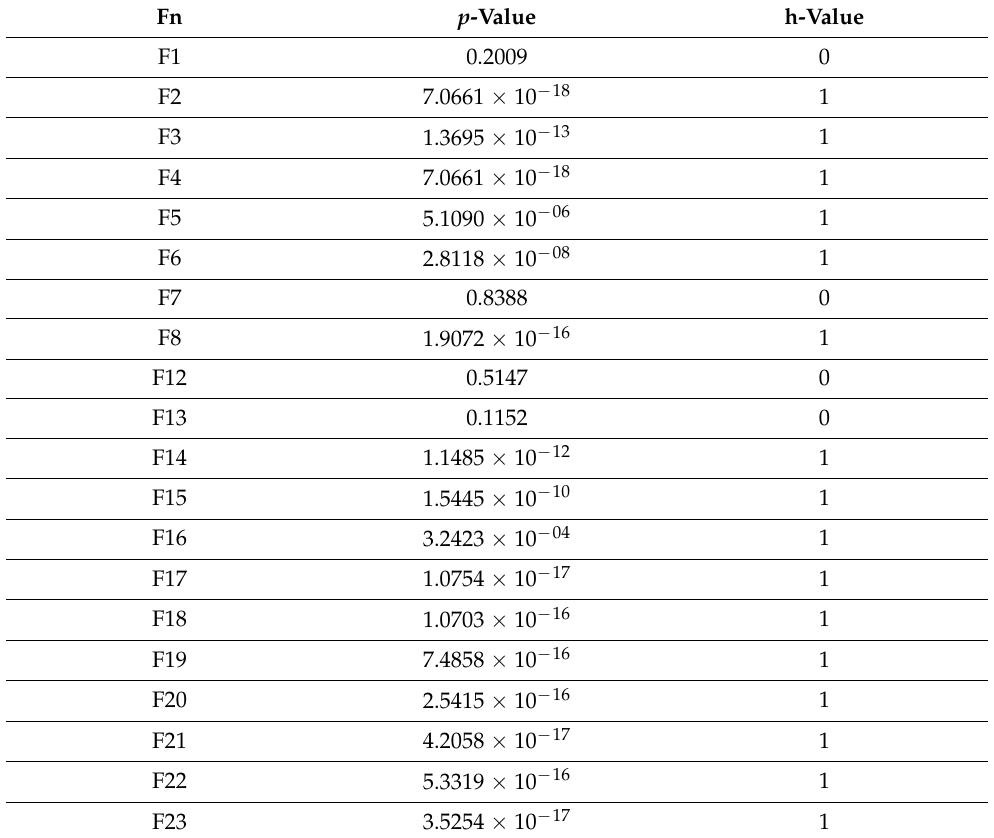
Table 10. Wilcoxon rank-sum test for D =